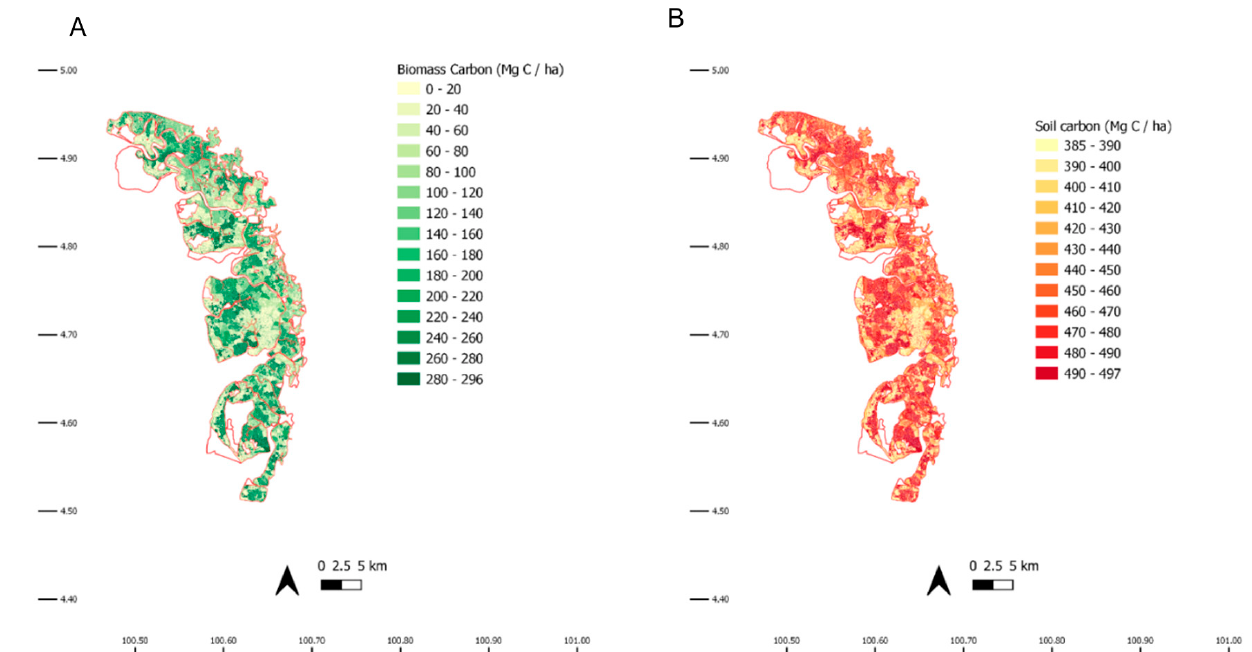
Figure 3. Carbon stock in mangrove biomass ( A ) and top first meter of soil ( B ) in the MMFR for the year 2016. Biomass data used to produce the map were derived from Lucas et al. [38] and Goessens et al. [30] and soil data were estimated from Adame et al. [35]. The white areas on the map are mostly protective forest zones for which biomass values were not directly available. Considering the total areas occupied by different forest zones (productive, restrictive would be equal to 36,212,677.1 Mg